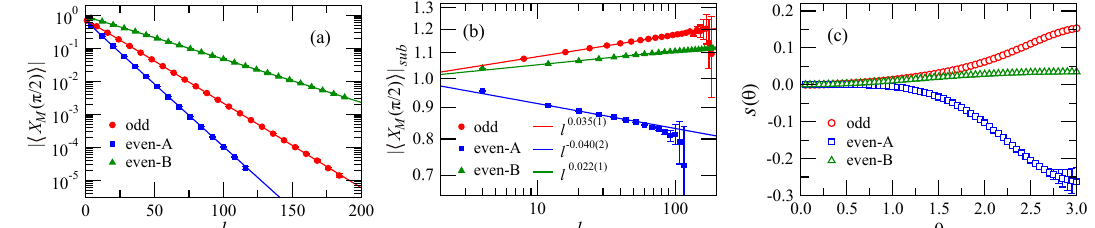
( θ ) 〉| for the H Figure 7: |〈 X model, all obtained with L = 96: (a) the disorder M J 1 − J 2 ( θ ) 〉| parameter and (b) its subleading term |〈 X as functions of l at θ = π/ 2, M sub for the three types of the region M . (c) s ( θ ) for the three types of the region M ,